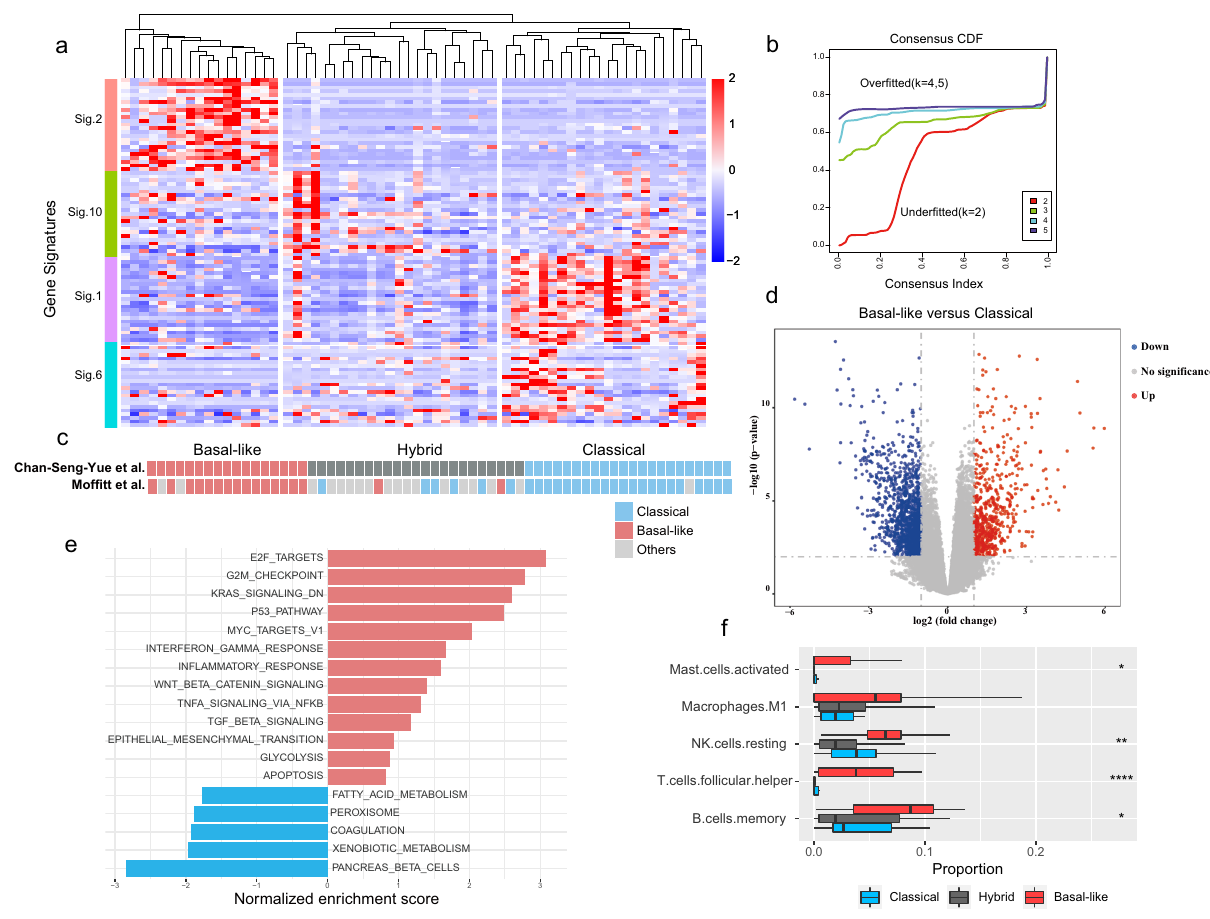
Fig. 1 Identi fi cation of PDAC subtypes by gene signatures. a Heatmap of the three consensus clusters based on 4 groups of tumor-related signatures determined by Chan-Seng-Yue et al. 23 . Expression values were scaled in the row direction. Signatures 2 and 10 are basal-related signatures, while signatures 1 and 6 are classical-related signatures. Our PDAC samples were classi fi ed into basal-like ( n = 17), hybrid ( n = 23) and classical ( n = 22) tumors. b Cumulative distribution function (CDF) plot from consensus clustering for different k values in our RNA-seq cohort. We chose k = 3 as the optimal cluster number. c Comparison of tumor clusters in ( a ) to the previous subtyping scheme by Mof fi tt et al. 6 . d Volcano plot showing differential gene expression in basal-like tumors compared with classical tumors. The up- and down-regulated genes were determined by adjusted P value < 0.01 and log 2 fold change >1 and <1, respectively. e Enriched pathways of differentially expressed genes identi fi ed by GSEA in basal-like versus classical tumors. The length of bars denotes the normalized enrichment score of each category. f The boxplot denotes the proportion of fi ve selected types of immune cells among basal-like, hybrid and classical tumors by CIBERSORTx. P values were determined by the Kruskal – Wallis test. * indicates the signi fi cance